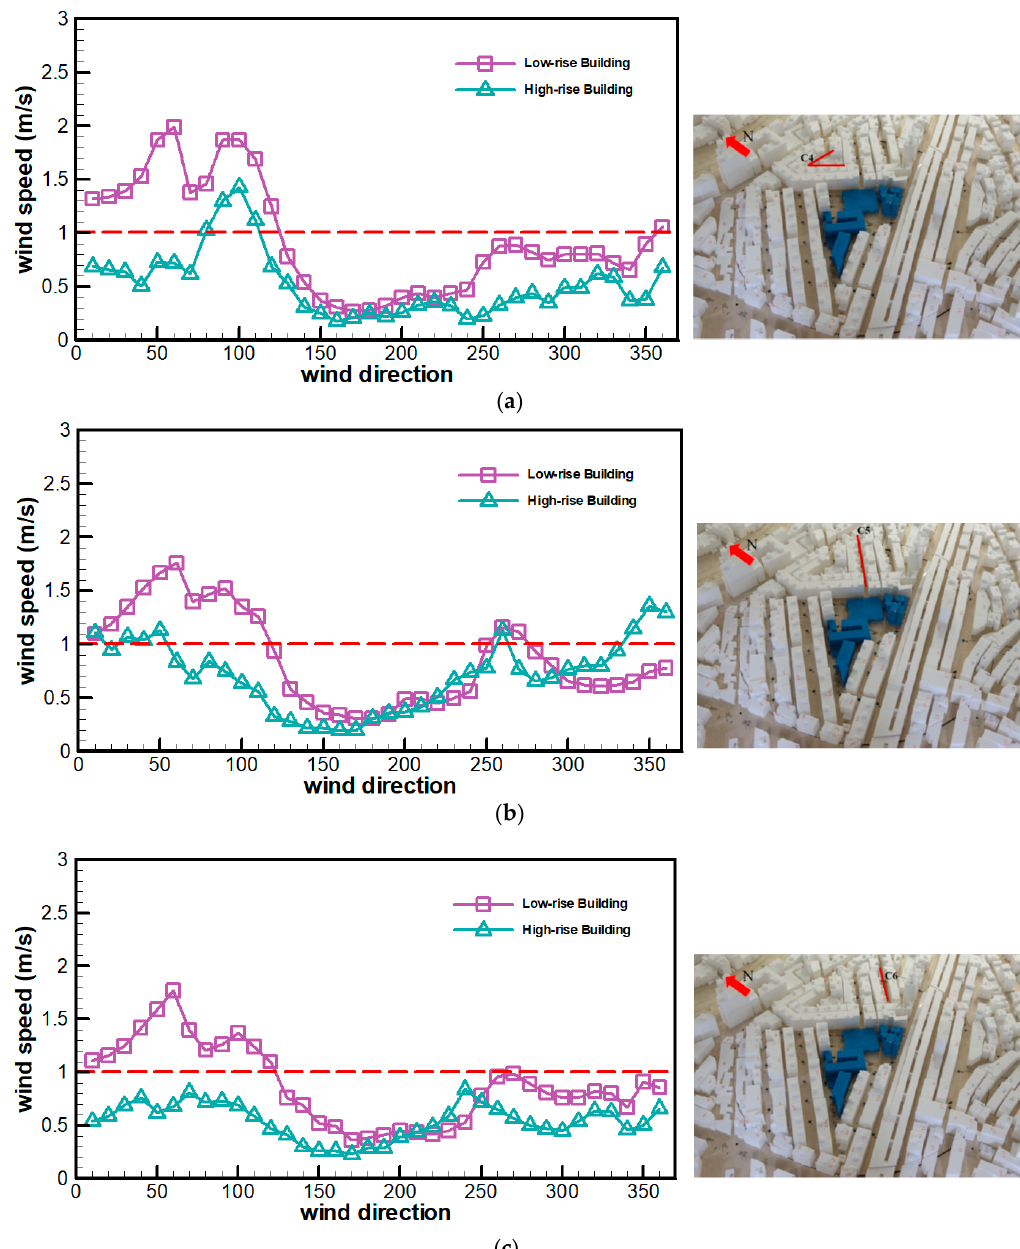
Figure 6. Characteristics of pedestrian wind environments in street canyons C4–C6 before and after